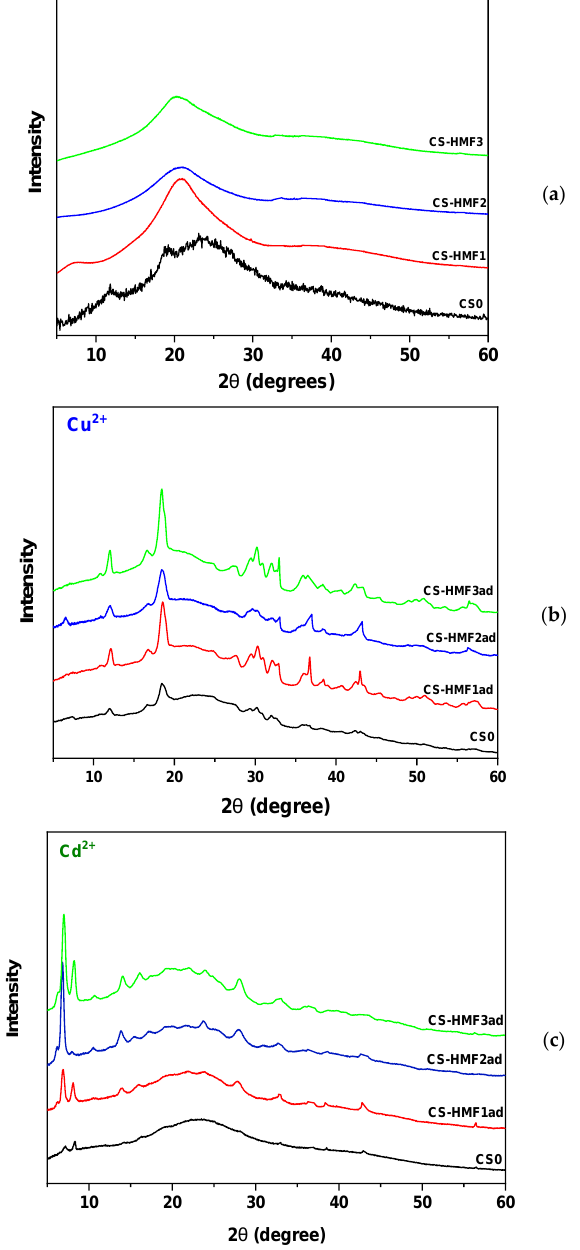
Figure 3. XRD patterns of the synthesized chitosan derivatives; ( a ) before adsorption; ( b ) after Cu 2+ adsorption; ( c ) after Cd 2+ adsorption.